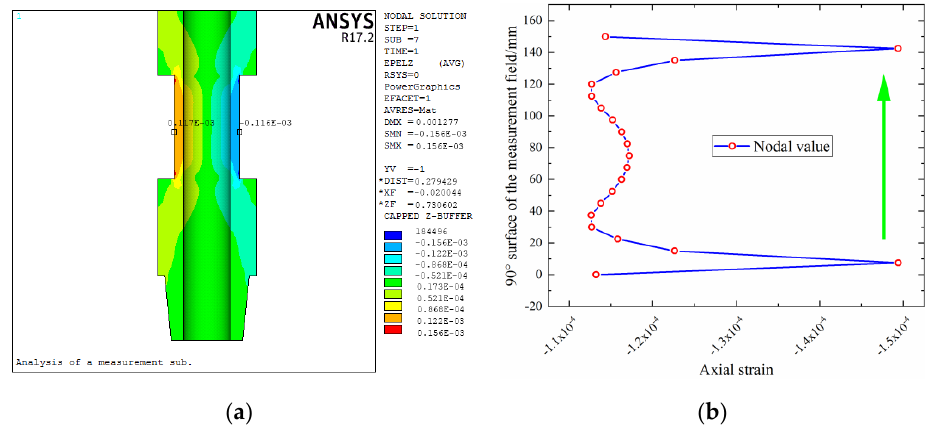
Figure 12. Strain distribution of elastic cell under bending moment: ( a ) contour; ( b ) axial distribution.